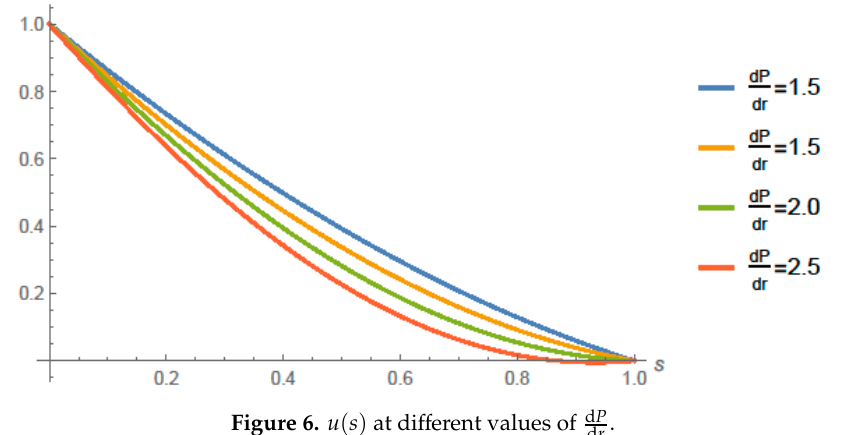
. d r (cid:2914)(cid:3045)